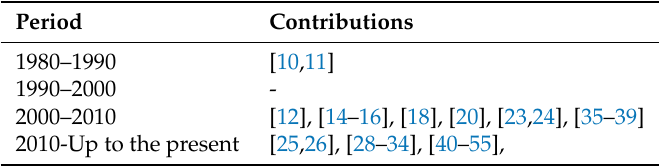
Table 1. Classification of the approaches by